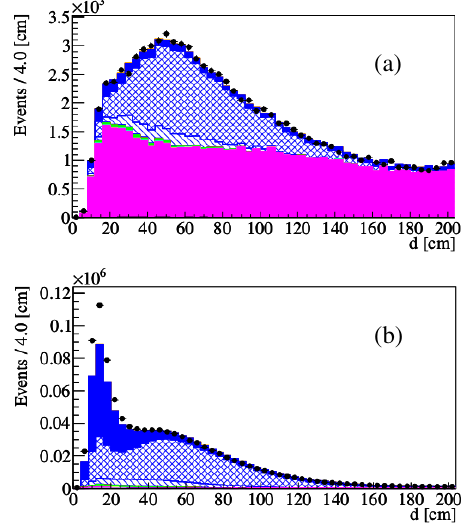
Figure 1. Distance d between the track intersection point with the EMC and the cluster centroid of the closest reconstructed photon. Plot (a) reports τ − → µ − ν µ ν τ candidates, plot (b) reports τ − → π − ν τ candidates. Data points are overlaid onto cumulated histograms representing simulated samples, drawn with the patterns documented in Figure ??